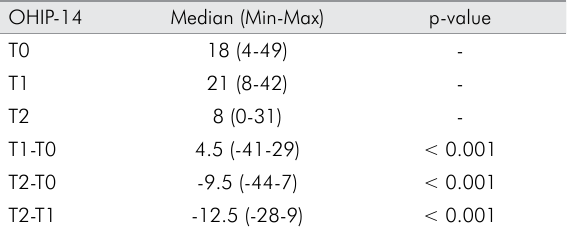
Table 2. The complete scores for each evaluation